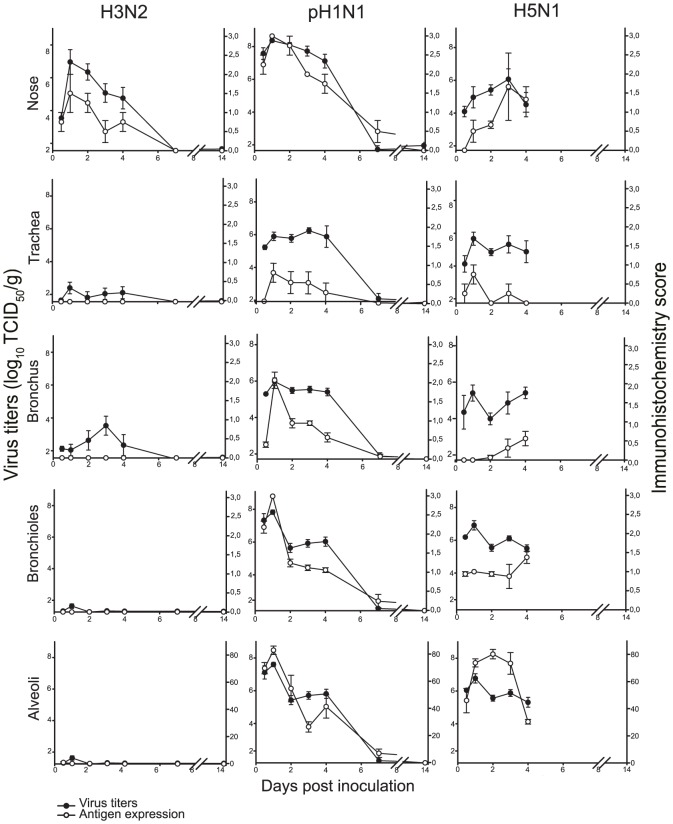
Virus distribution in the respiratory tracts of ferrets inoculated with different influenza viruses.The data are depicted as median values and standard errors of the mean. Virus titers and antigen expression as demonstrated by immunohistochemistry scores are comparable for ferrets inoculated with H3N2 and pH1N1. Ferrets inoculated with H5N1 have highest antigen expression in the alveoli while virus titers are comparable for all parts of the respiratory tract, suggesting that most virus originated from the lower respiratory tract. The average cut-off values for the respiratory tissues are: nose 1.6 (range 1.3–1.8), trachea 1.6 (1.4–1.9), bronchus 1.6 (range 1.3–2.0) and lung 1.3 (range 0.9–1.4) log10 TCID50. Immunohistochemistry scores in nose, trachea, bronchi, and bronchioles are scored from 0 to 3, and those in the alveoli are scored as a percentage.